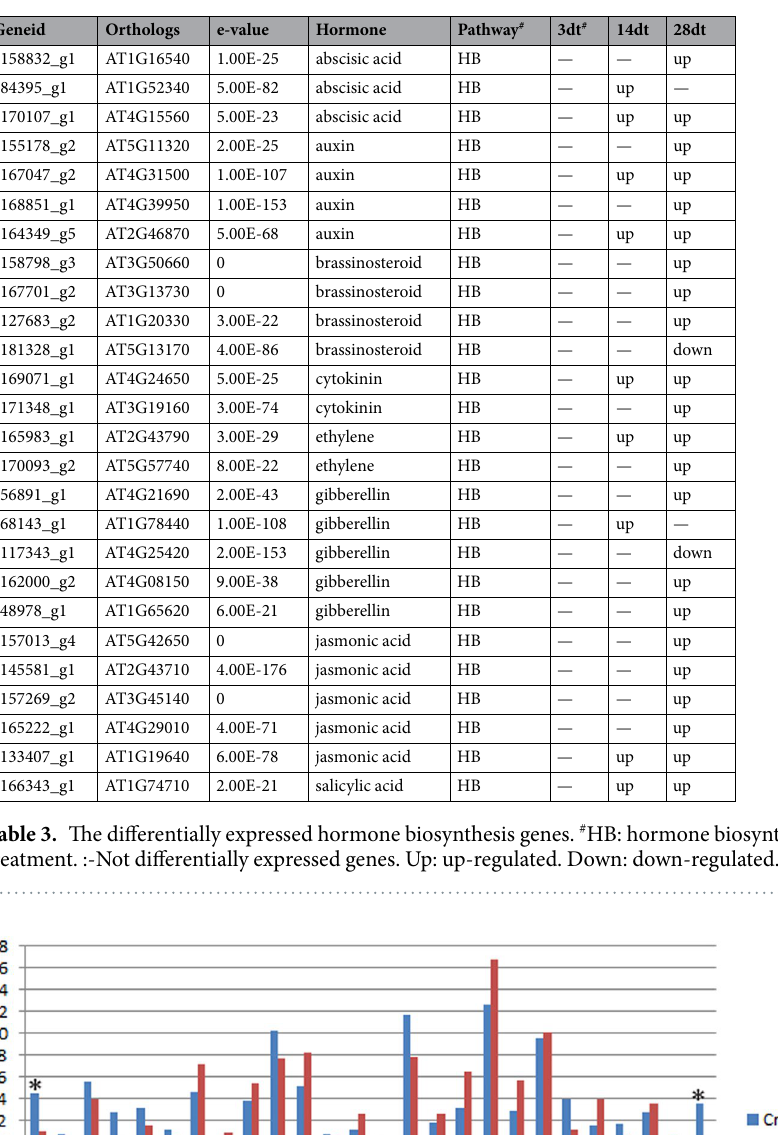
Figure 6. The category of differentially expressed transcriptional factors. ( A ) The number of differential type transcriptional factors. Y-axis represents the number of TF and x-axis represent the type of TFs. ( B ) The expression pattern of WRKY genes. Red indicate up-regulated and black indicate no significant difference. ( C ) The phylogenetic tree of 14 differentially expressed WRKY genes. The tree was constructed using the neighbor- joining method as implemented in PHYLIP 3.2. Numbers on internal nodes are the percentage bootstrap support values (1000